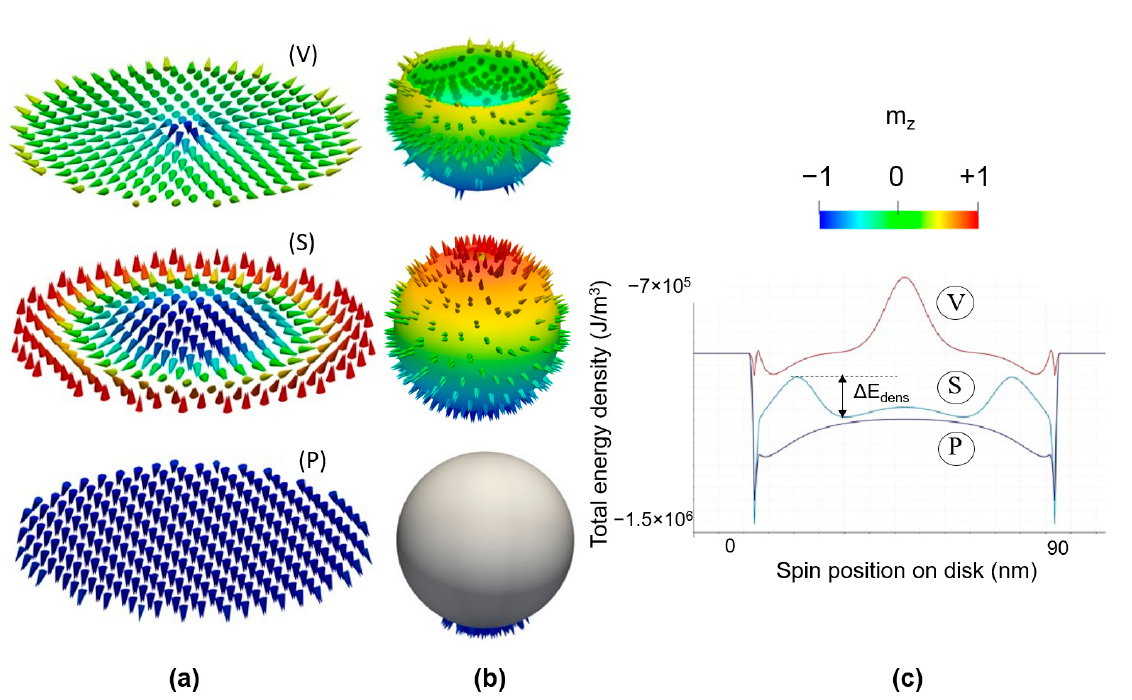
Figure 14. Micromagnetic configuration in vector field glyph representation ( a ) and ( b ) projections on the Bloch sphere of the corresponding magnetization vector for: (V) = magnetic vortex states ( Q ≈ – 0.5), (S) = magnetic skyrmionic states ( Q ≈ − 1) and (P) = perpendicularly magnetized (PM) states; ( c ) Line profile of the total energy density of the spins within the ferromagnetic disk.